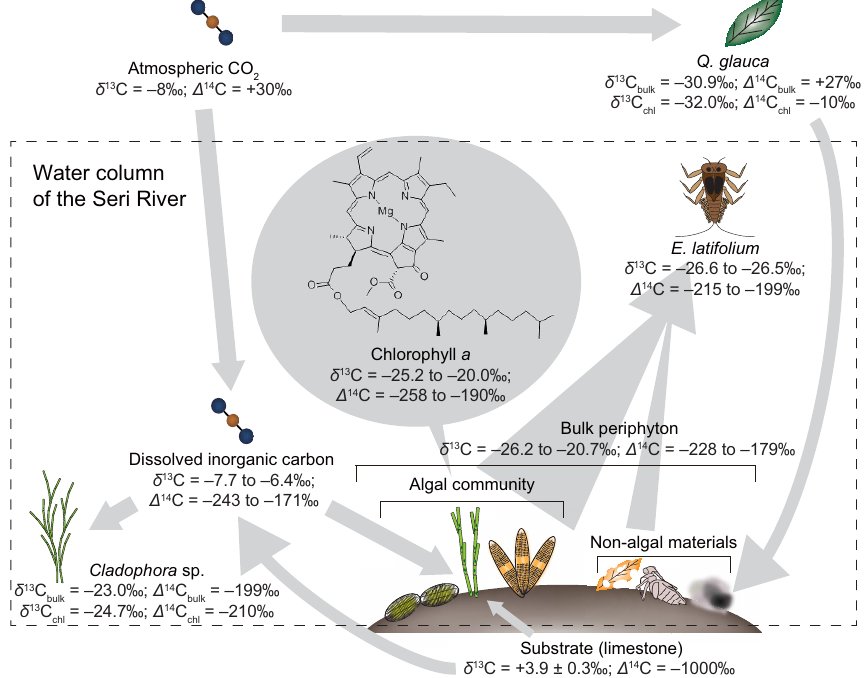
Figure 3. Schematic view of the carbon cycle at the study site (Seri River) constrained by δ 13 C and (cid:49) 14